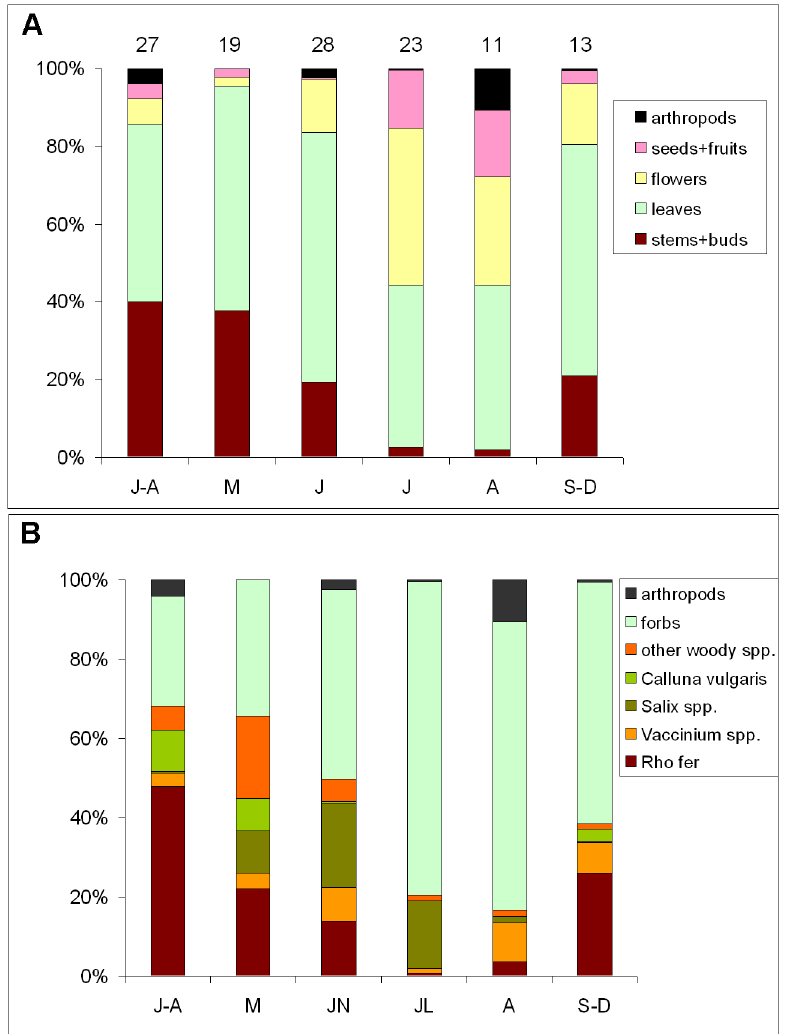
Fig 1. Food types of Rock ptarmigan in Western Pyrenees and their monthly variation. The three samplings years and autumn/winter months have been pooled. Food items are expressed in broad (morphological) (A) and morpho-taxonomical (B) food categories. Numbers above bars indicate sample size.